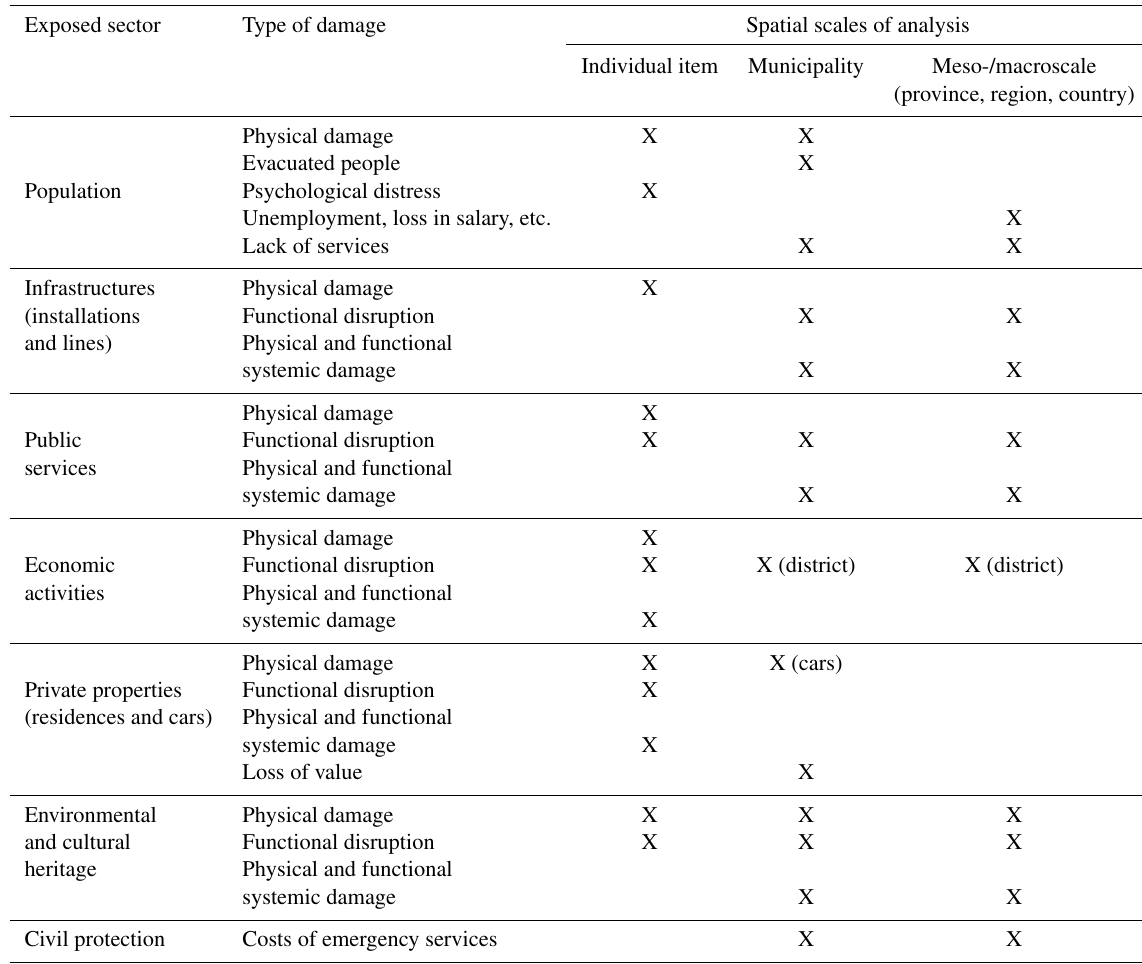
Table 1. The structure of the model according to three main logical axes: sectors, types of damage and spatial scale. Exposed sector Type of damage Spatial scales of analysis Individual item